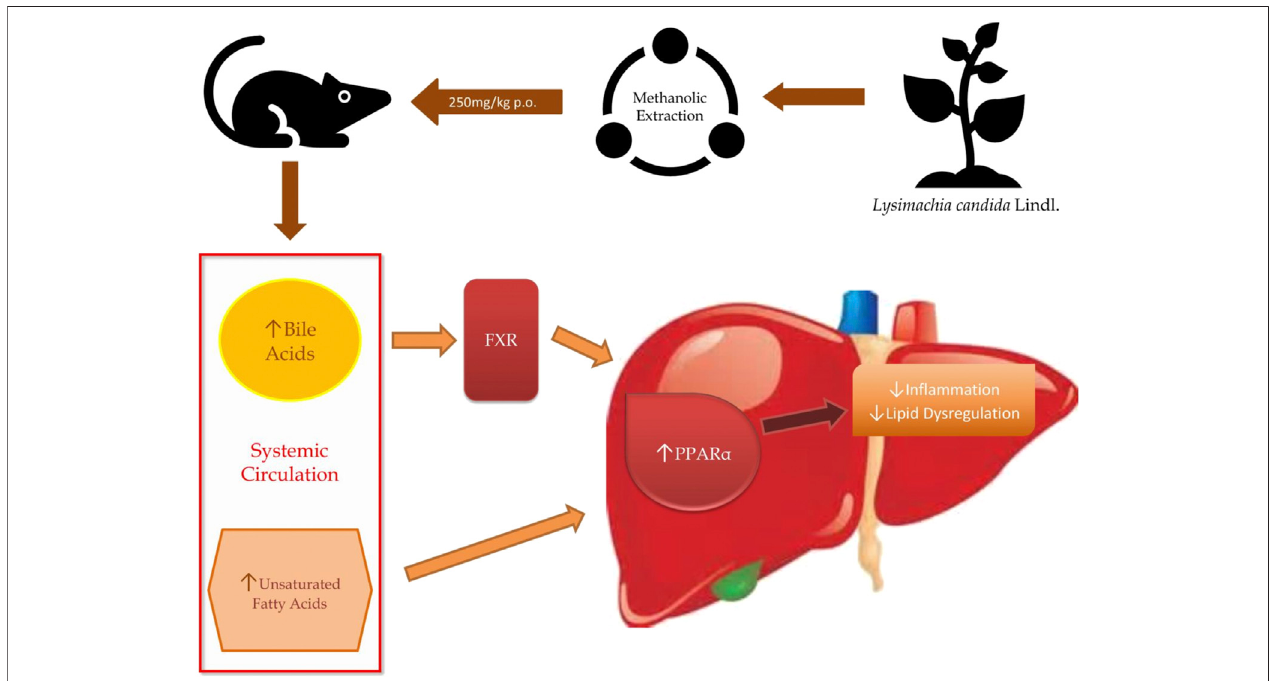
FIGURE 7 | Schematic diagram representing the results and possible pathway unveiled by our study.